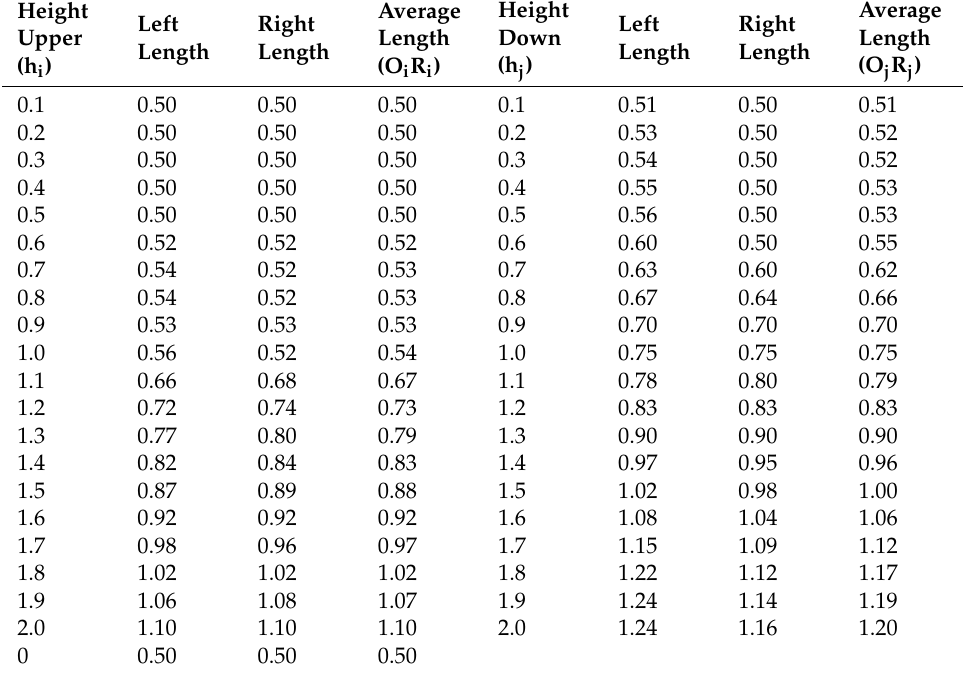
Table 1. The coordinate values of the cross-sectional profile of case S1. (Unit: mm). Height